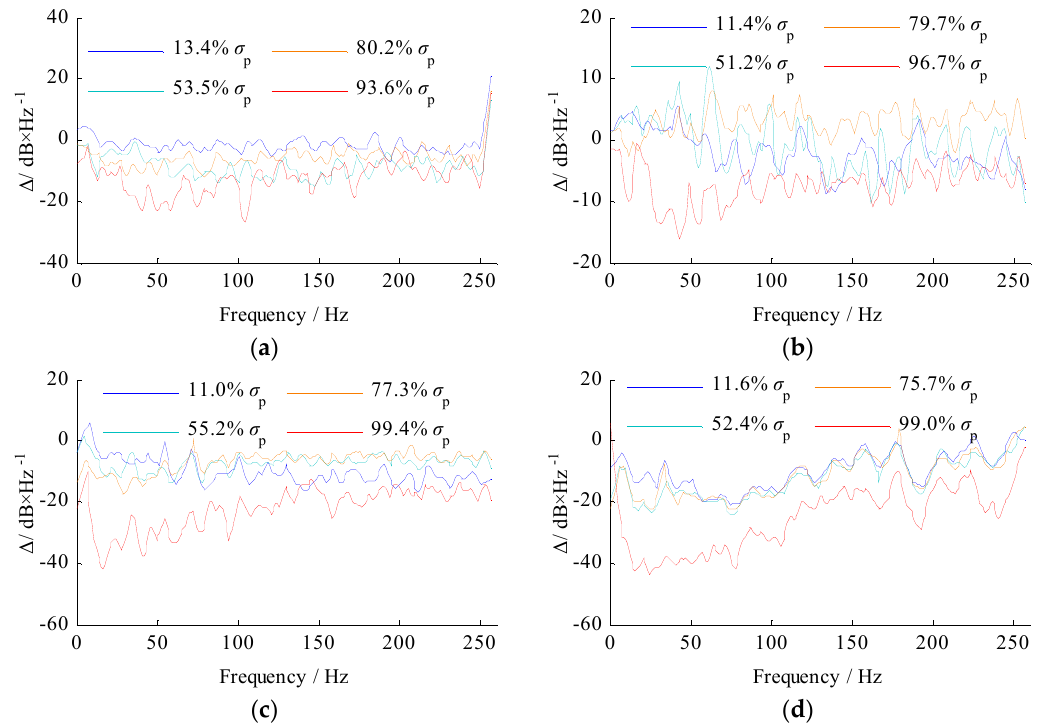
Figure 10. Power spectral density attenuation of different moisture content ( a ) A5; ( b ) B5; ( c ) C4; ( d ) D4.